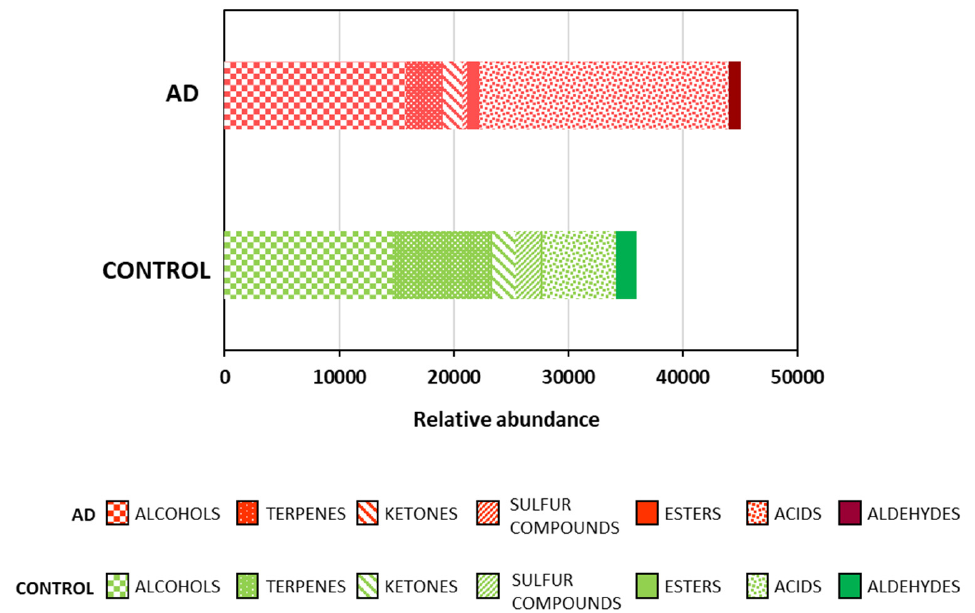
Figure 1. Relative abundance of the volatile organic compounds (VOCs) in the feces from the control subjects and the Alzheimer’s disease (AD) patients; (n = 10, control subjects; n = 12, AD patients). Due to the high number of the determined volatile compounds, a multivariate analysis was used to determine the variables with a higher responsibility in the differentiation between the healthy subjects and the AD patients. First, the entire dataset was examined using a principal component analysis (PCA) to explore the data. As shown in Figure 2A,B, the scores and loadings plot displays three principal components (PCs) necessary to build a tridimensional plot. The projection of PC1, PC2 and PC5 grouped the samples according to the subject’s condition, revealing that the volatile profile of the feces was different between subjects with and without AD. Therefore, PC1 explained 16.14% and PC2 13.88% of the total variance. Although the percentage explanation of the variance was not very high, it must be considered that the fecal VOCs were the sum of multiple factors, as stated in the introduction. Therefore, the variance was expected to be distributed among these factors. Within the PCs, PC1 described the separation of the AD patient samples, placed on the positive side, from the controls, placed on the negative side (Figure